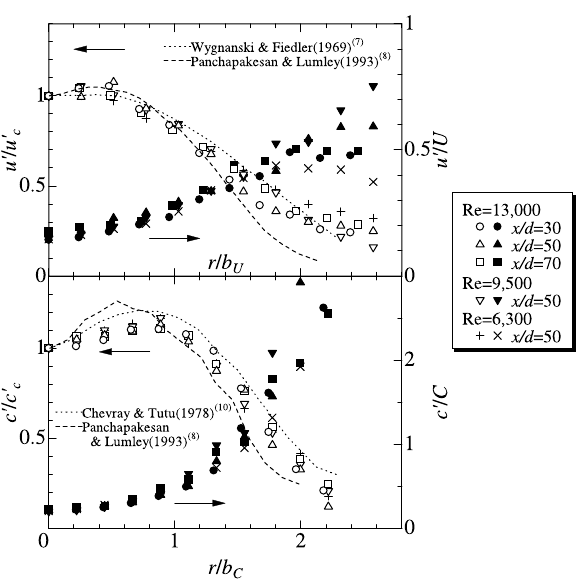
Fig. 4 Radial profiles of the r.m.s. values of the axial velocity and